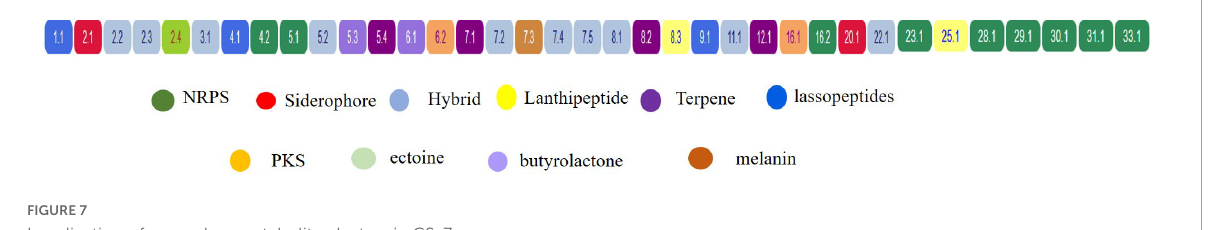
FIGURE7 Localization of secondary metabolite clusters in CS-7.